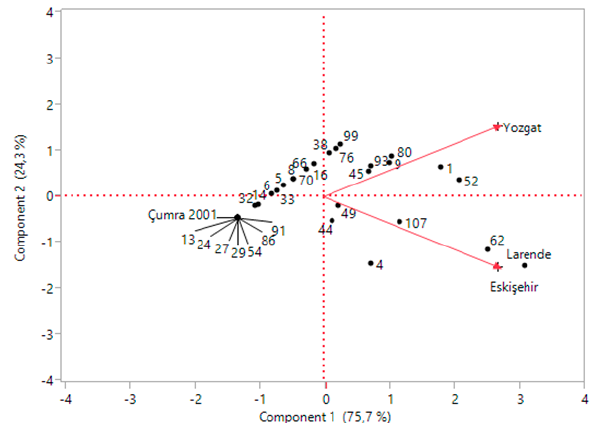
Figure 2. Biplot based on PCA analysis of the mean disease incidences of barley landraces inoculated with two isolates of Drechslera graminea .